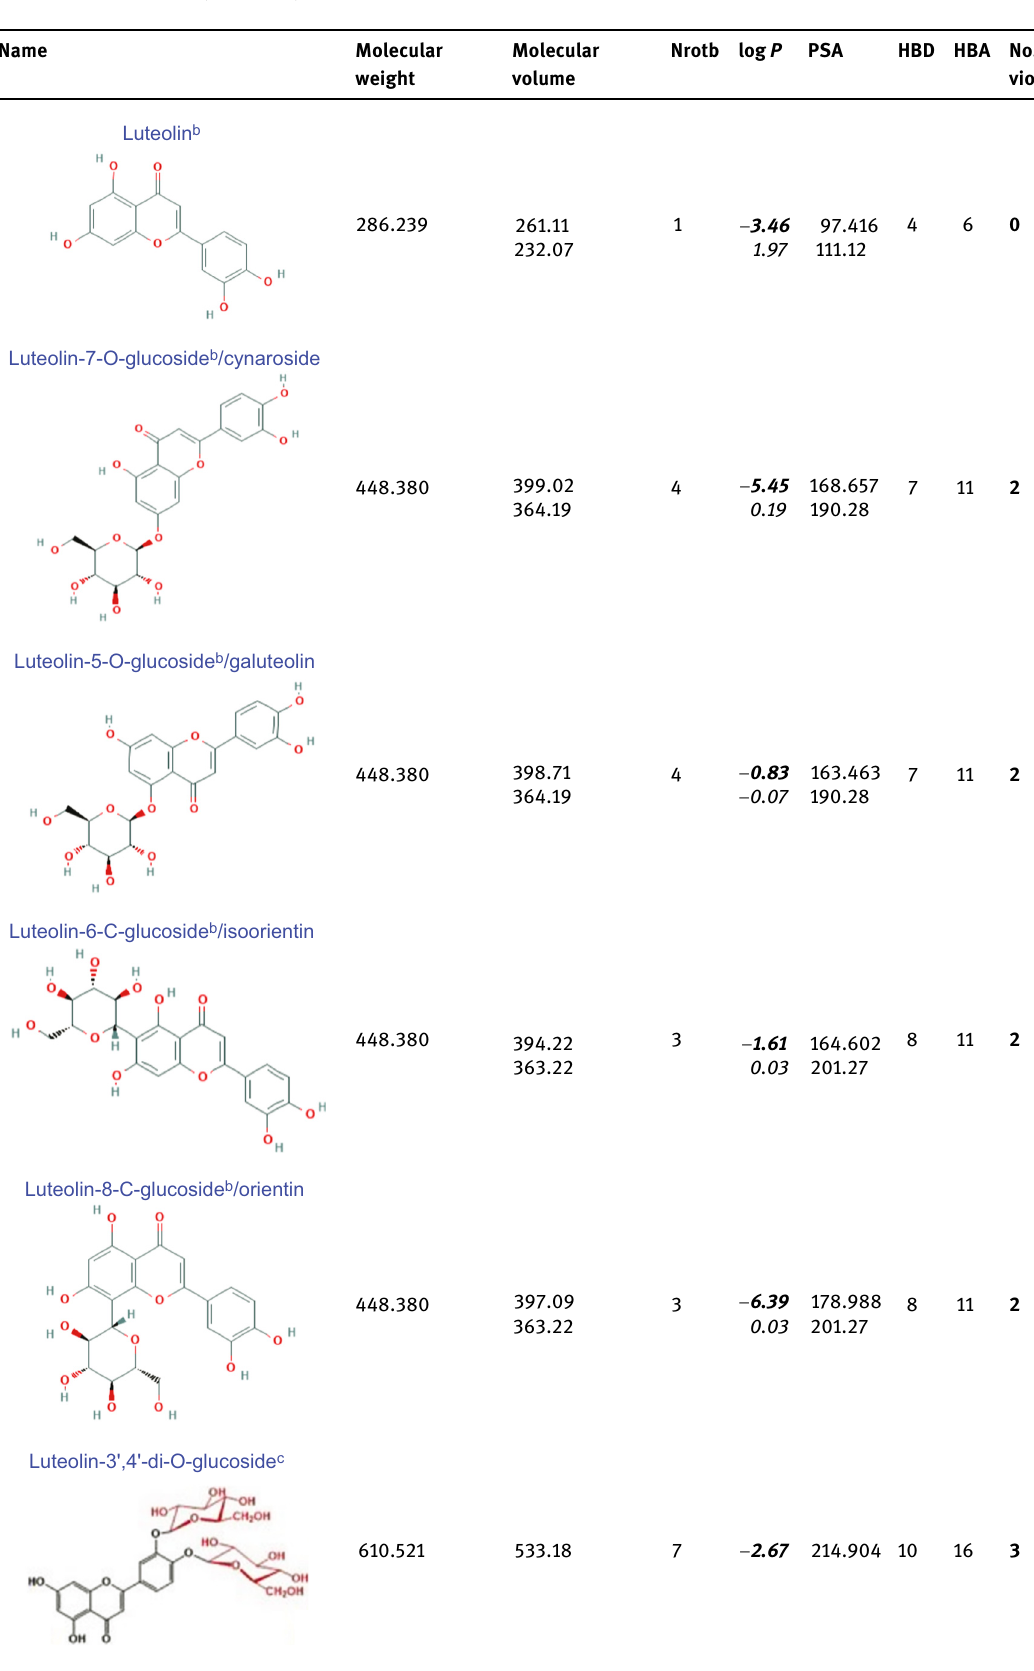
Table 2: Drug - likeness predicted parameters for luteolin and its derivatives